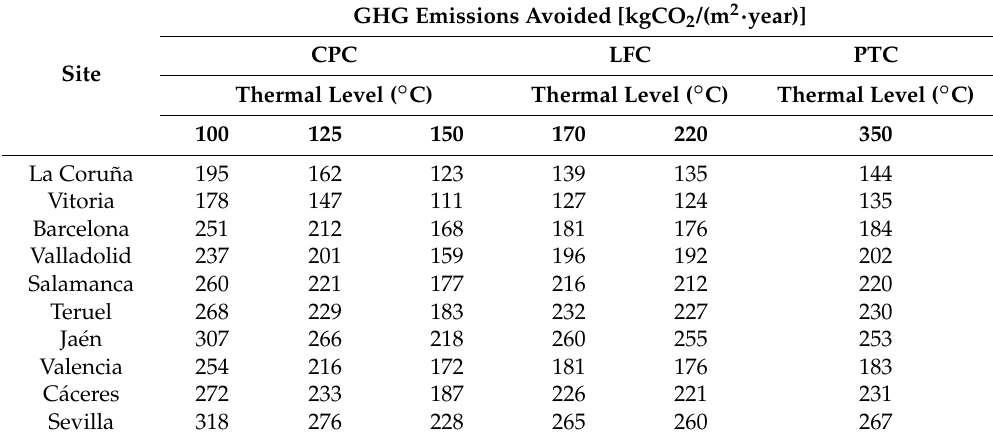
Table 30. GHG emissions annually avoided by the use of solar technologies instead of diesel oil.